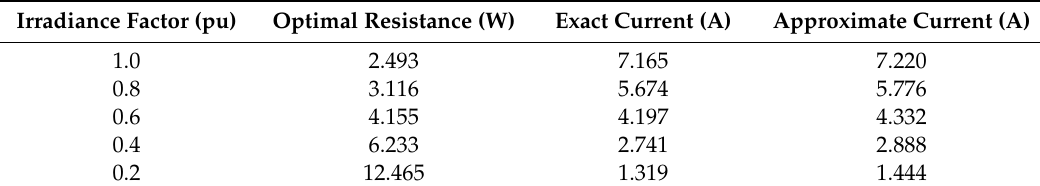
Table 2. Verification of Equations (1) and (2).